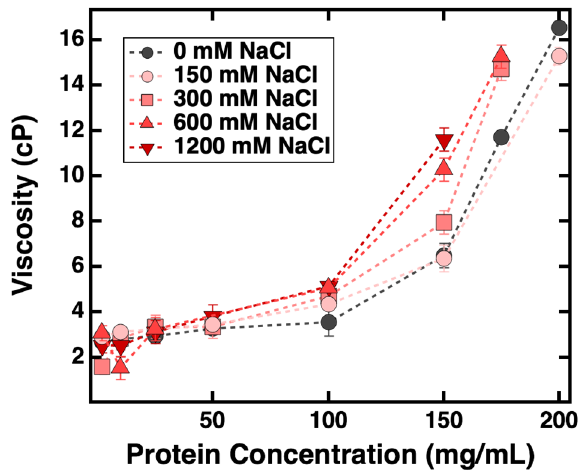
Figure 7. Viscosity of ASA-IgG2 solutions prepared at various mAb and NaCl concentrations. Dotted lines are included to guide the eye. Error bars represent one standard deviation from three separate measurements.